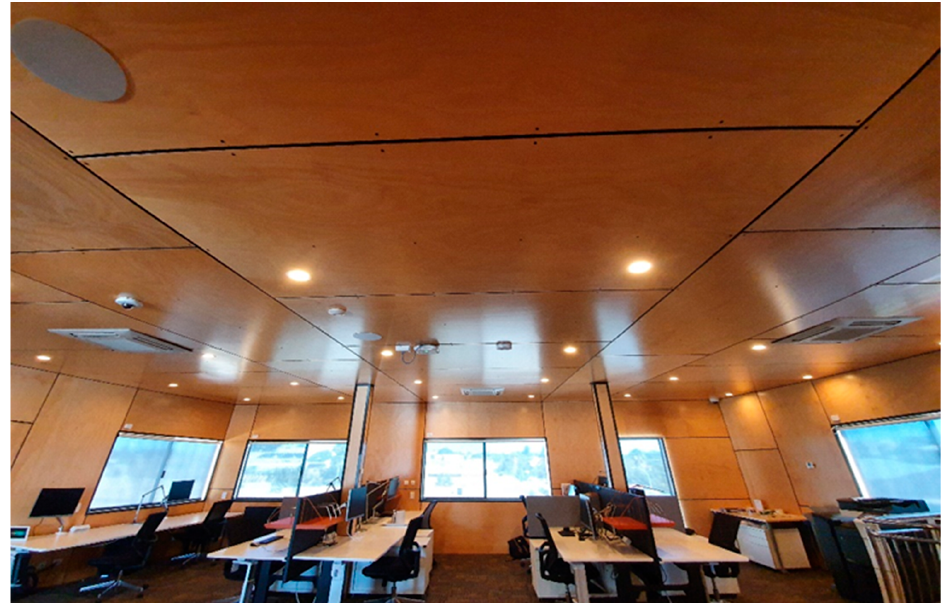
Figure 6. First floor of the prototype building L3. The wall and roof cladding is disassemblable, showing the frames granting access to insulation and systems. This feature allows low waste production and low environmental impact during the L3 operation stage.